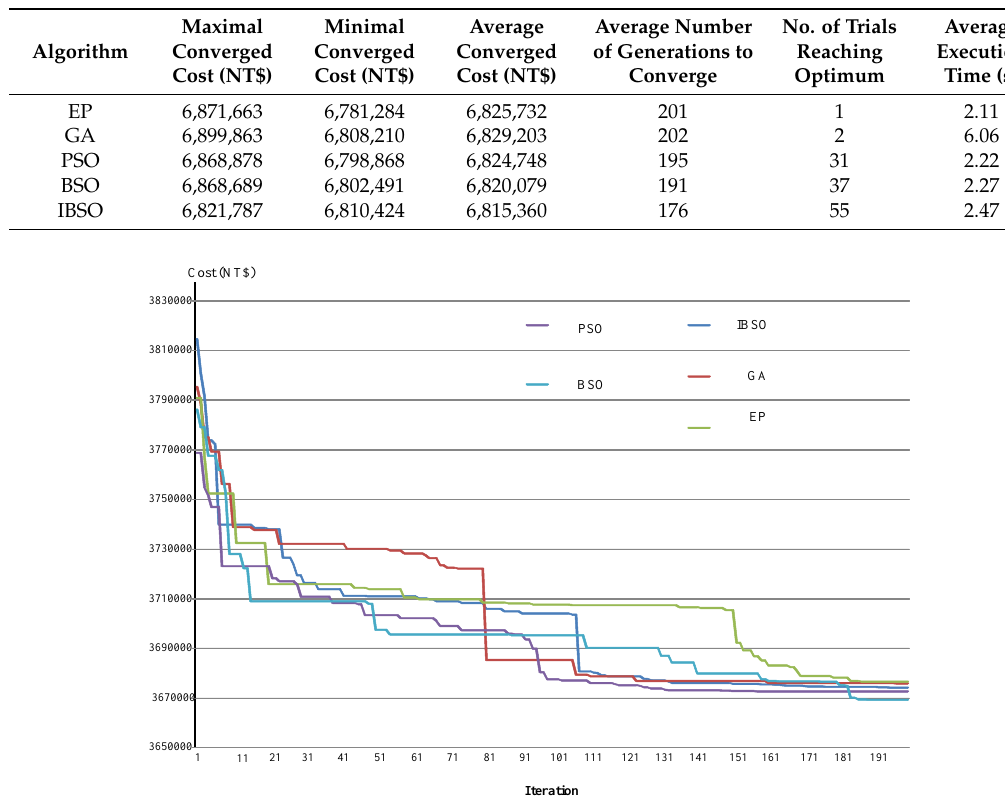
Figure 13. Convergence characteristics of the EP, GA, PSO, BSO, and IBSO algorithms in the grid-connected scenario.